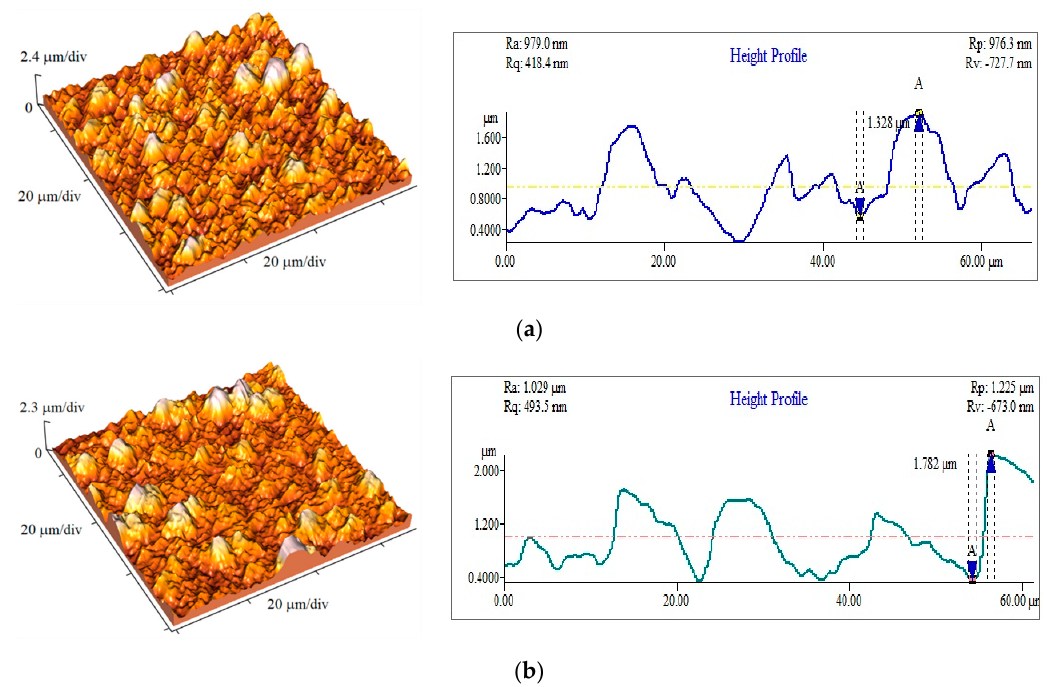
Figure 7. The AFM images and the corresponding line section analyses of Cu coatings obtained by the PC regimes: ( a ) j A = 120 mA cm – 2 , and ( b ) j A = 140 mA cm – 2 . In all experiments: t c = 5 ms; t p = 5 ms, PC regimes: ( a ) j = 120 mA cm − 2 , and ( b ) j A ν = 100 Hz. Thickness of coatings: δ = 40 µ m. Scan area: 70 × 70 µ m 2